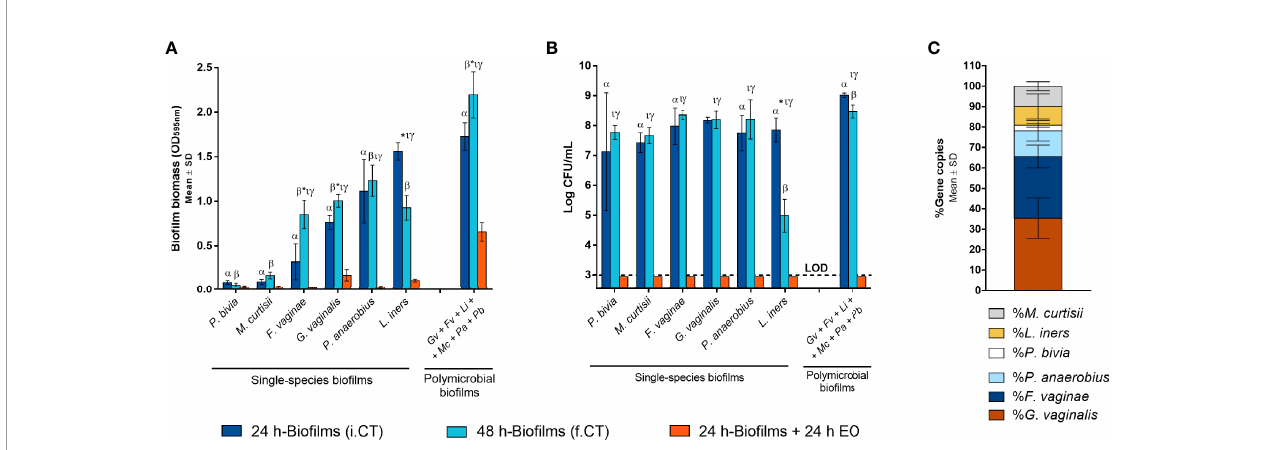
FIGURE 1 | Single-species and polymicrobial BV bio fi lms. (A) Biomass quanti fi cation of the single-species and polymicrobial bio fi lms prior to and after EO exposure using crystal violet method. (B) Culturable cells quanti fi cation from the single-species and polymicrobial bio fi lms prior to and after EO treatment, by CFU method. (C) Determination of the percentage distribution of each bacterial species in 24 h polymicrobial BV bio fi lm, by qPCR. i.CT stands for initial control, before the medium replacement; f.CT stands for fi nal control, after incubation with fresh medium. Statistically signi fi cant differences between polymicrobial vs single-species bio fi lms are represented with a for 24 h incubation time and with b for 48 h incubation time (two-way ANOVA and Dunnett ’ s multiple comparisons test, p < 0.05). Values are signi fi cantly different for * i.CT vs f.CT, t i.CT vs EO, and g f.CT vs EO (two-way ANOVA and Tukey ’ s multiple comparisons test, p < 0.05). Gardnerella vaginalis ( Gv ); Fannyhessea vaginae ( Fv ); Lactobacillus iners ( Li ); Mobiluncus curtisii ( Mc ); Peptostreptococcus anaerobius ( Pa ); Prevotella bivia ( Pb ); Essential oil (EO); Limit of detection (LOD).